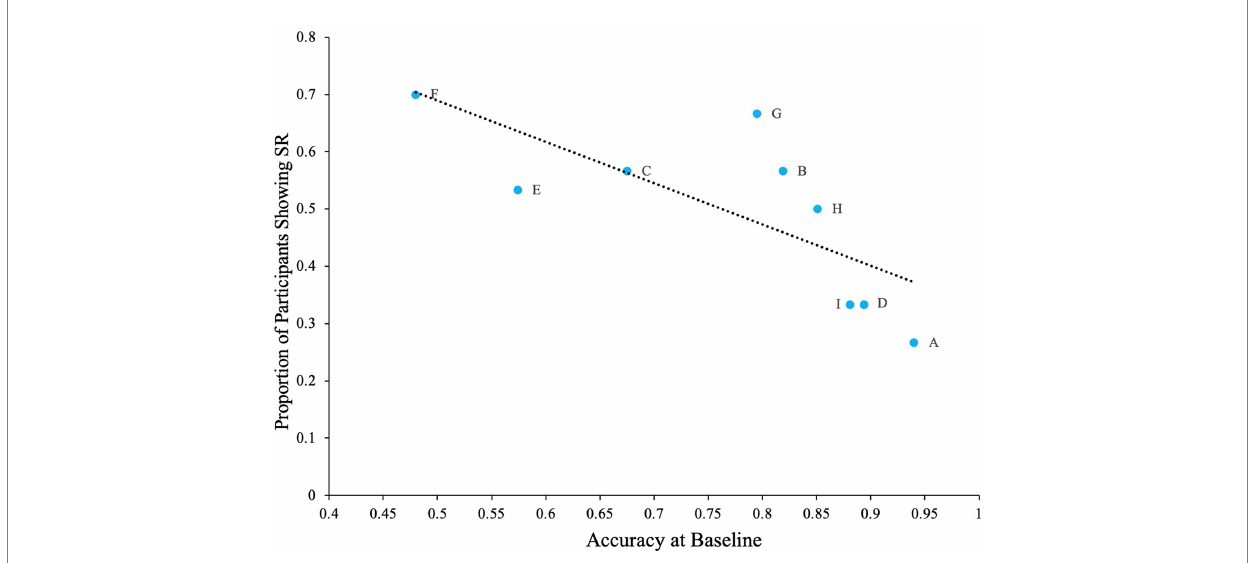
FIGURE 13 The proportion of participants showing SR for each letter in relation to the letter’s baseline accuracy. Dashed line indicates the regression line (trendline). Plot shows negative association between baseline accuracy and proportion of participants showing SR. The baseline is accuracy of participants at zero external noise